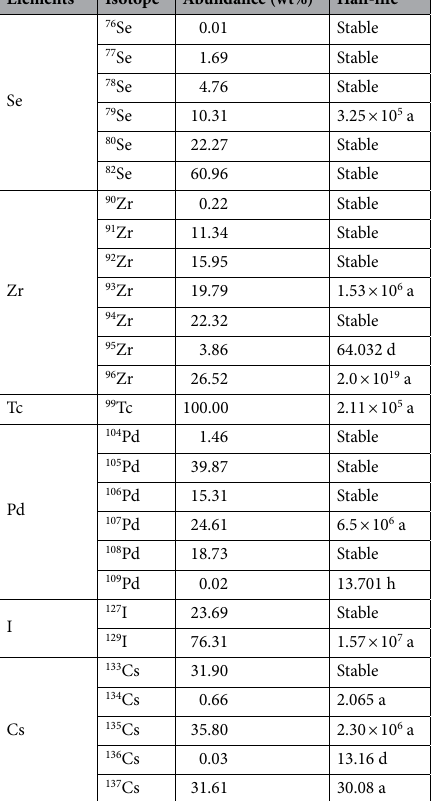
Table 4. Isotope abundance and half-life of loaded LLFPs